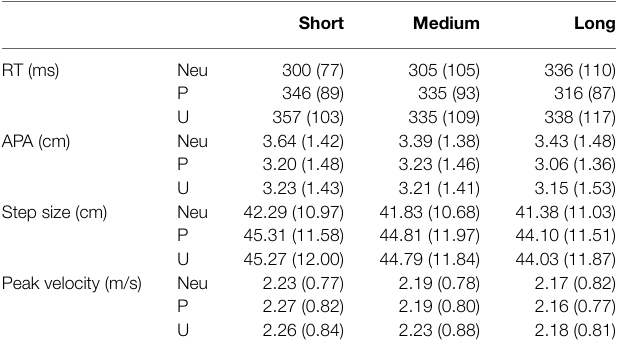
TABLE 4 | Mean ( + SD) of the GI variables for all three duration and emotion categories. Short